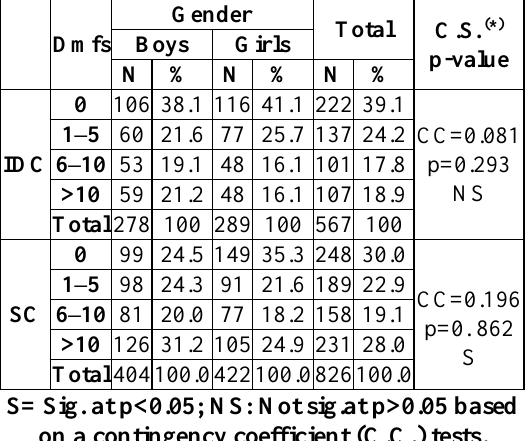
Table 4: Caries severity dmfs of children distributed according to gender.